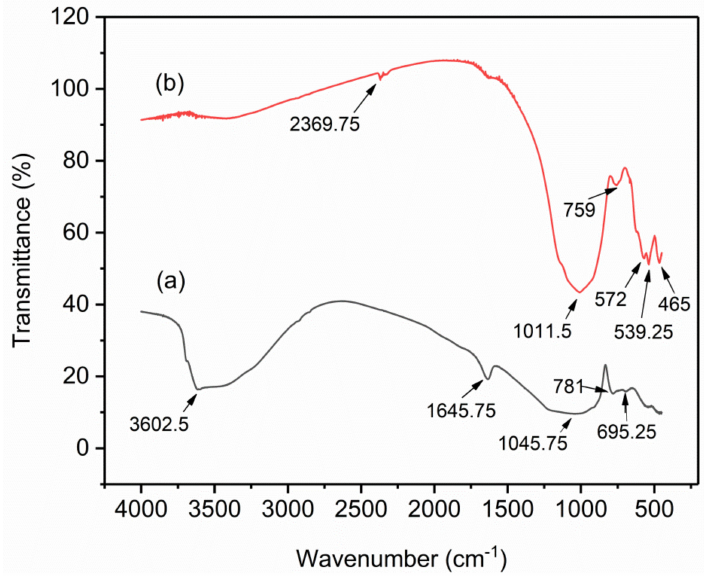
Figure 2. Fourier-transform infrared (FTIR) for ( a ) VPum and ( b ) VSco.